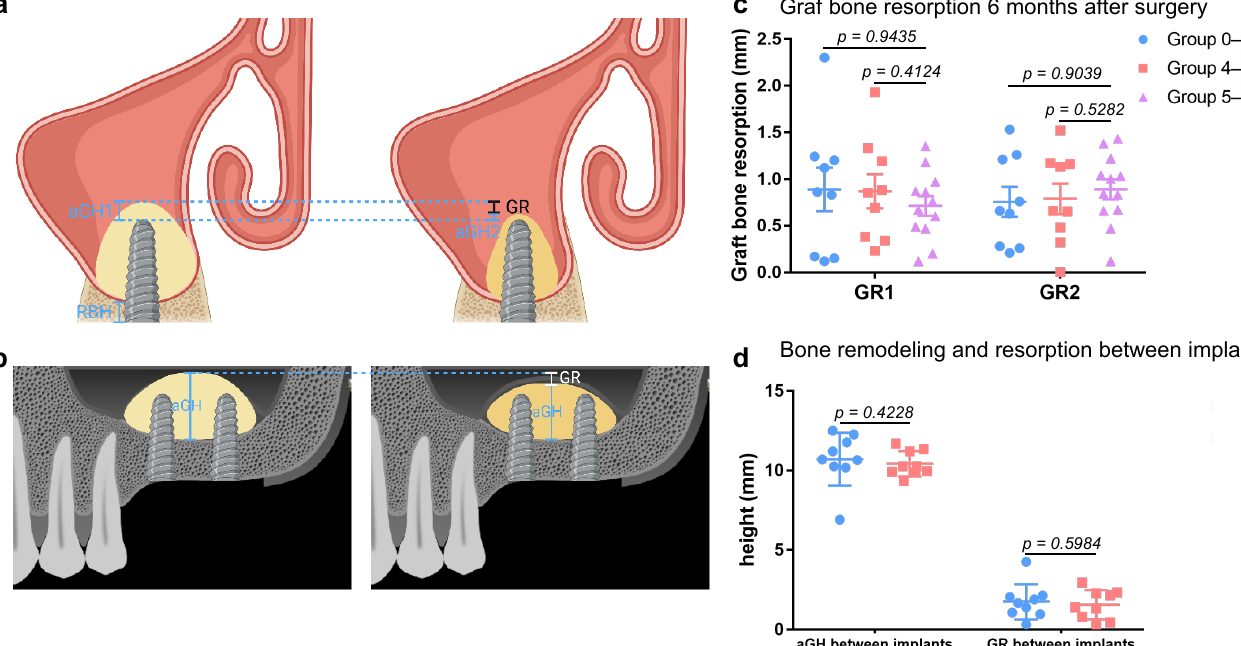
Figure 6. Analysis of bone remodeling and resorption. ( a ) schematic diagram of aGH and GR at implant site. ( b ) schematic diagram of aGH and GR between implants. ( c ) graft bone resorption at implant site 6 months after surgery. ( d ) bone remodeling and resorption between implants. RBH: the preoperative distance between the alveolar bone crest and the maxillary sinus floor in the coronal plane at T0. Sinus width: the preoperative distance between the lateral sinus wall and the medial sinus wall at 5 mm height level from the sinus floor in the coronal plane at